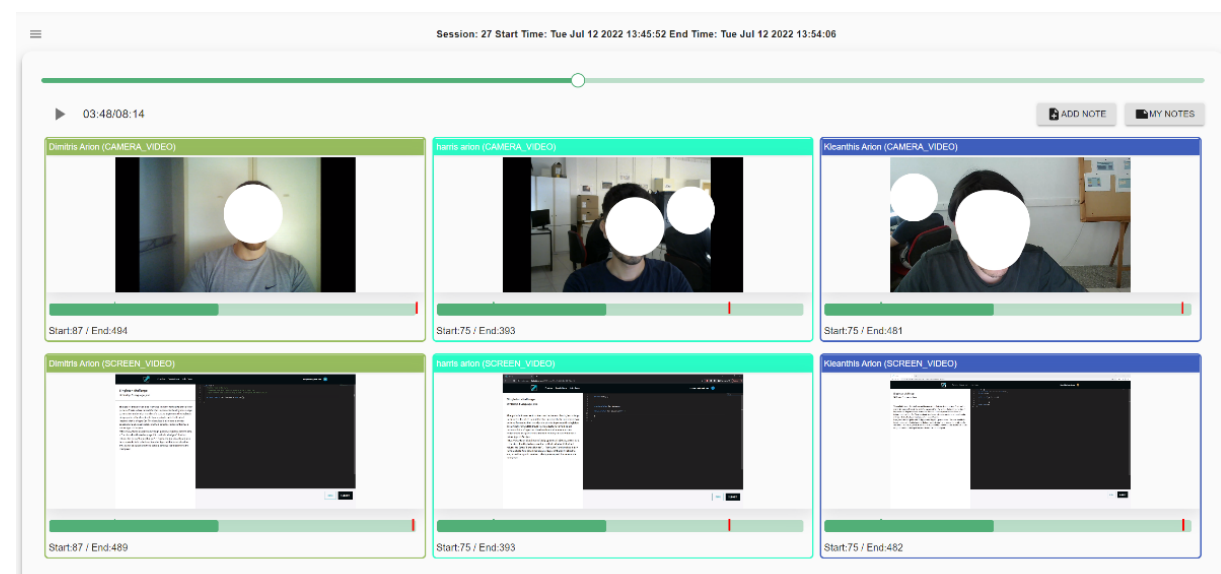
Figure 9. Open Studio with ordered